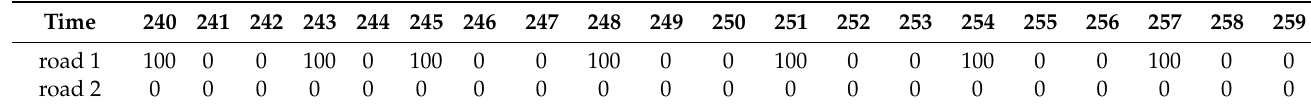
Table 4. Flow ratio (%) of roads 1 and 2 to road